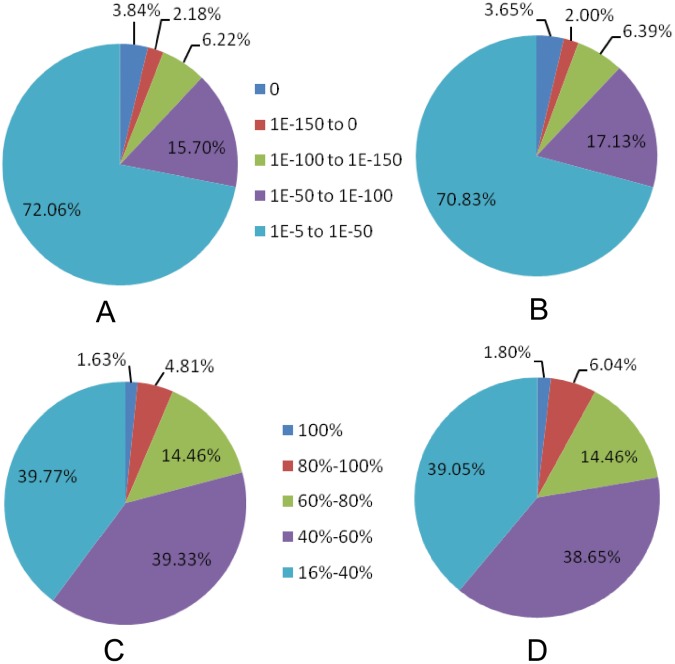
The annotation of assembled All-unigenes.The results of sequence similarity examination conducted against the NCBI Nr (A and B) and Swiss–Prot protein databases (C and D) were shown, respectively. The legend in the middle of A and B represents the E-value and the one between C and D represents the percentage of different identity.